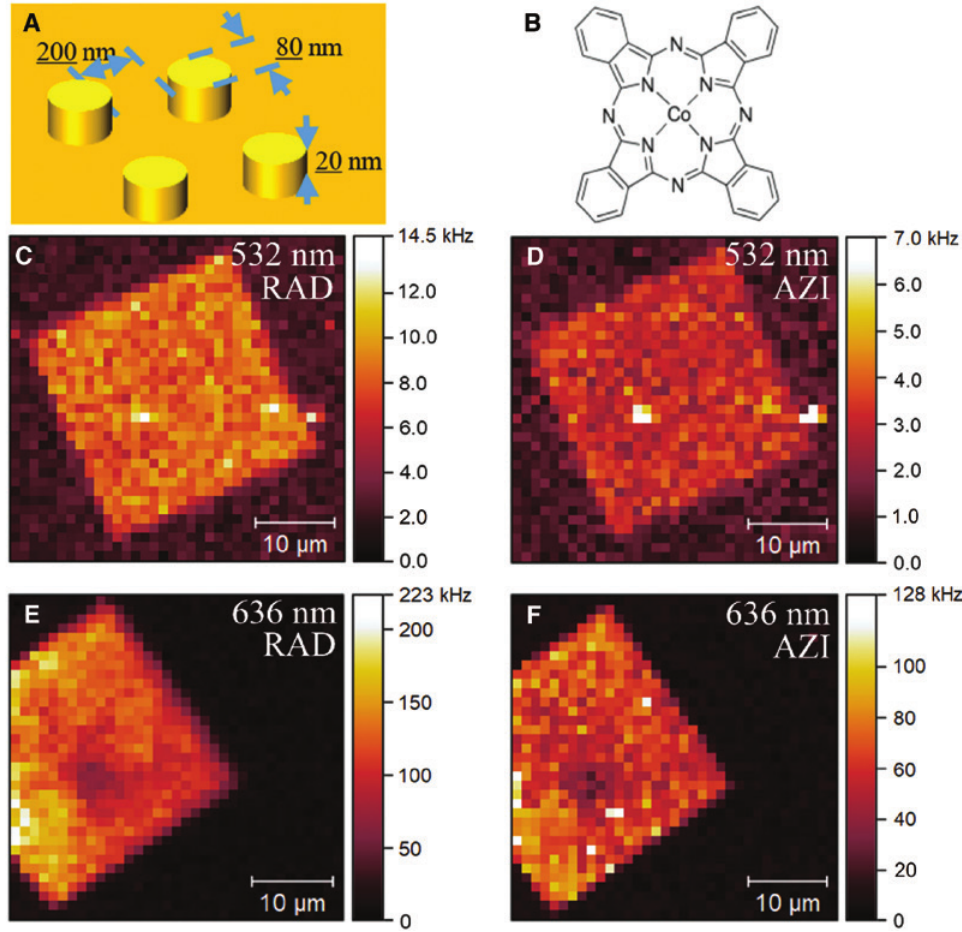
Figure 2: Confocal optical images of CoPc on nanostructured Au. (A) Schematic diagram of a CoPc thin film deposited on a nanostructured gold substrate. (B) Chemical structure of CoPc. (C–F) Confocal optical images from a Au nanodisk array using 532 nm excitation and 636 nm excitation, respectively. For (C) and (E), a radial incident polarization is used, while for (D) and (F) an azimuthal polarization is used. The abbreviations “RAD” denotes the radially polarized mode, while “AZI” is the azimuthally polarized mode. The excitation power at the sample is ~ 200 μ W for the 636 nm excitation and ~ 50 μ W for the 532 nm excitation.